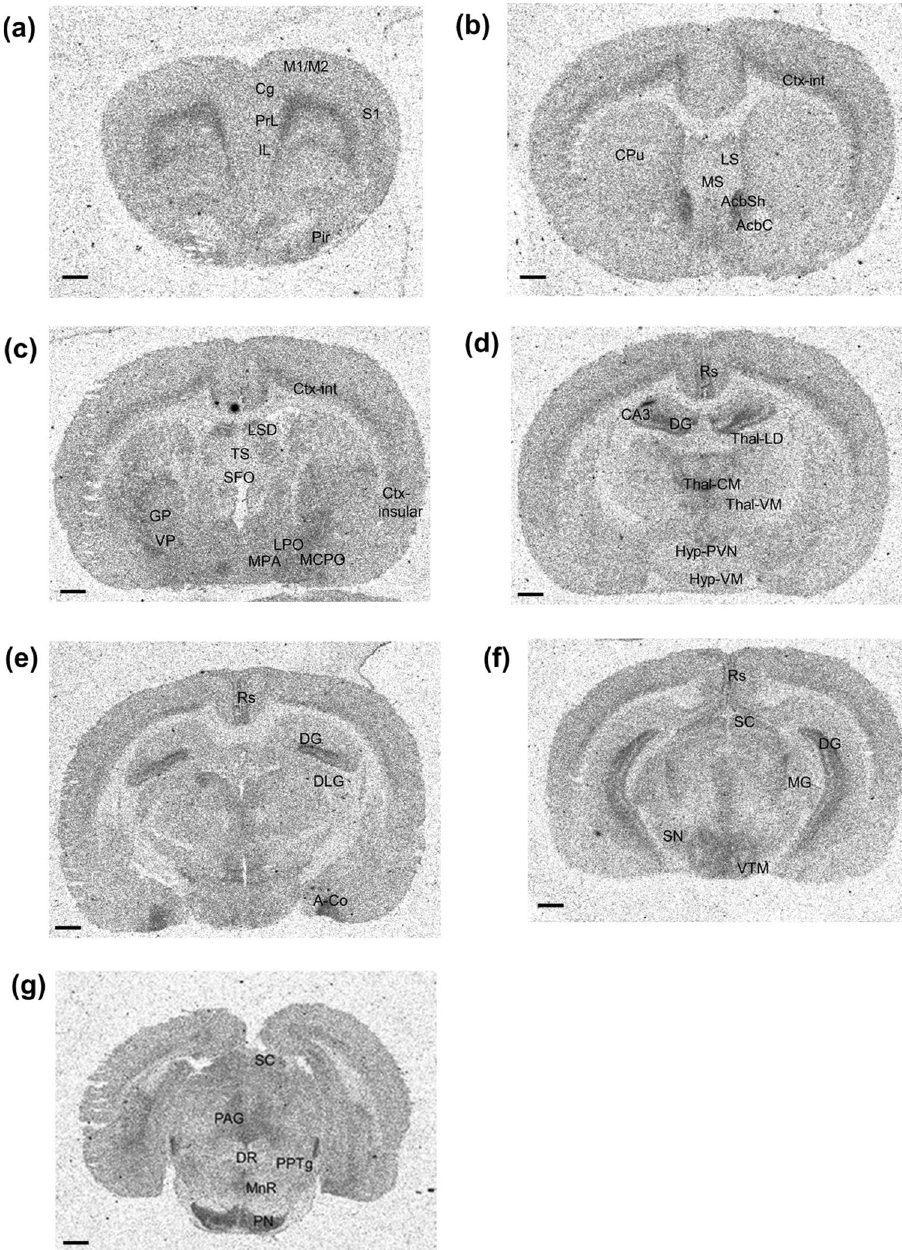
Figure 3. Distribution of [ 3 H]-EMPA binding sites in rat brain sections. Representative images of [ 3 H]- EMPA total binding in different rat brain sections are shown including: ( a ) infralimbic (IL), prelimbic (PrL), cingulate (Cg), motor (M1/M2), somatosensory (S1), and piriform (Pir) cortical regions; ( b ) internal layer of cortex (Ctx-int), lateral septum (LS), medial septum (MS), caudate putamen (CPu), nucleus accumbens shell (AcbSh), and nucleus accumbens core (AcbC); ( c ) internal layer of cortex (Ctx-int), insular cortex (Ctx- insular), lateral septum dorsal part (LSD), triangular septum (TS), subfornical organ (SFO), globus pallidus (GP), ventral pallidum (VP), and hypothalamus: medial preoptic area (MPA), lateral preoptic area (LPO) and magnocellular preoptic area (MCPO); ( d ) retrosplenial cortex (Rs), hippocampus: dentate gyrus (DG) and CA3, thalamus: laterodorsal nucleus (Thal-LD), central medial nucleus (Thal-CM), ventromedial nucleus (Thal-VM), hypothalamus: ventromedial nucleus (Hyp-VM), and paraventricular nucleus (Hyp-PVN); ( e ) retrosplenial cortex (Rs), hippocampal dentate gyrus (DG), dorsolateral geniculate nucleus of the thalamus (DLG), and cortical amygdala (A-Co). ( f ) Retrosplenial cortex (Rs), hippocampal dentate gyrus (DG), superior colliculus (SC), medial geniculate nucleus of the thalamus (MG), ventral tuberomammillary nucleus of the hypothalamus (VTM), and substantia nigra (SN); ( g ) superior colliculus (SC), periaqueductal gray (PAG), dorsal raphe nucleus (DR), median raphe nucleus (MnR), pedunculopontine tegmental nucleus (PPTg), and pontine nuclei (PN). All brain samples were collected at approximately the same time (ZT2–3). Scale bar represents 1